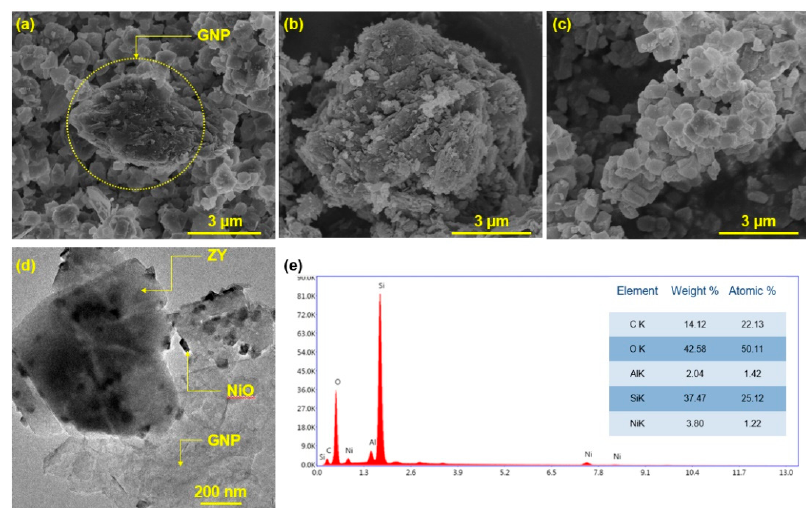
Figure 4. SEM images of ( a ) GNP/NiO-ZY, ( b ) GNP, and ( c ) NiO-ZY, TEM image of ( d ) GNP/NiO- ZY, and ( e ) EDX analysis of GNP/NiO-ZY.